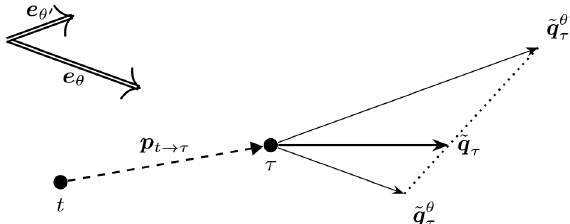
Figure 5. Illustration of how wind-direction-specific simple pseudo-gradient vectors combine into an averaged simple pseudo- gradient vector.